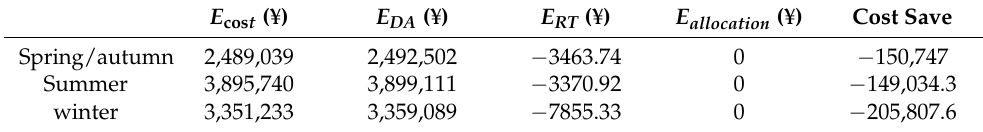
Table 9. Electricity costs with comprehensive optimization